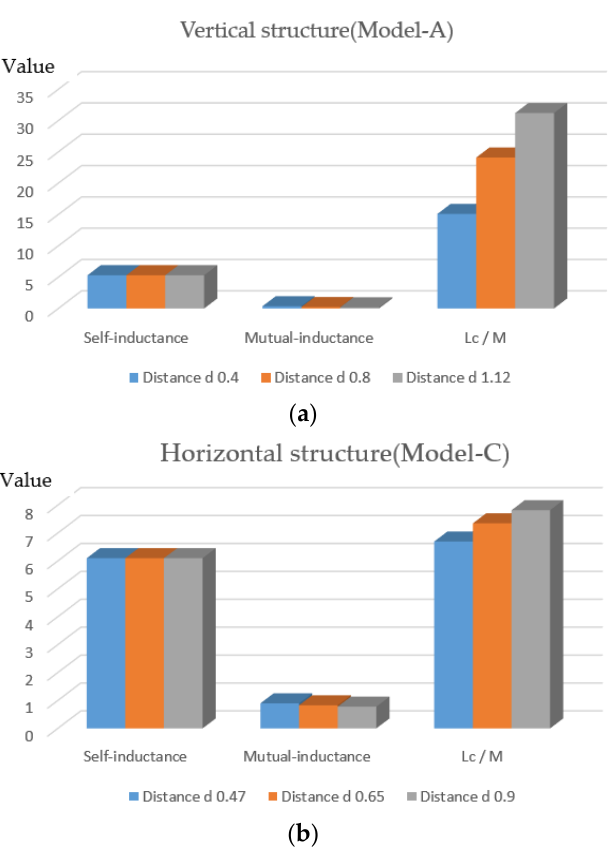
Figure 7. FEM results under different distances: ( a ) vertical structure coil model and ( b ) horizontal structure coil model.